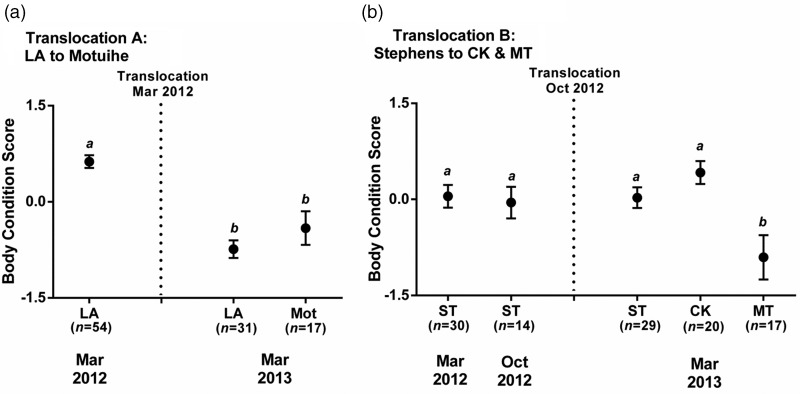
Body condition scores (log mass/log snout–vent length) in populations of tuatara (S. punctatus) translocated to: (a) Motuihe Island from Lady Alice Island (LA); and (b) Cape Kidnappers Sanctuary (CK) and Sanctuary Mountain Maungatautari (MT) from Stephens Island (ST). Data points (means ± SEM) that share identical letters are not significantly different (P > 0.05).